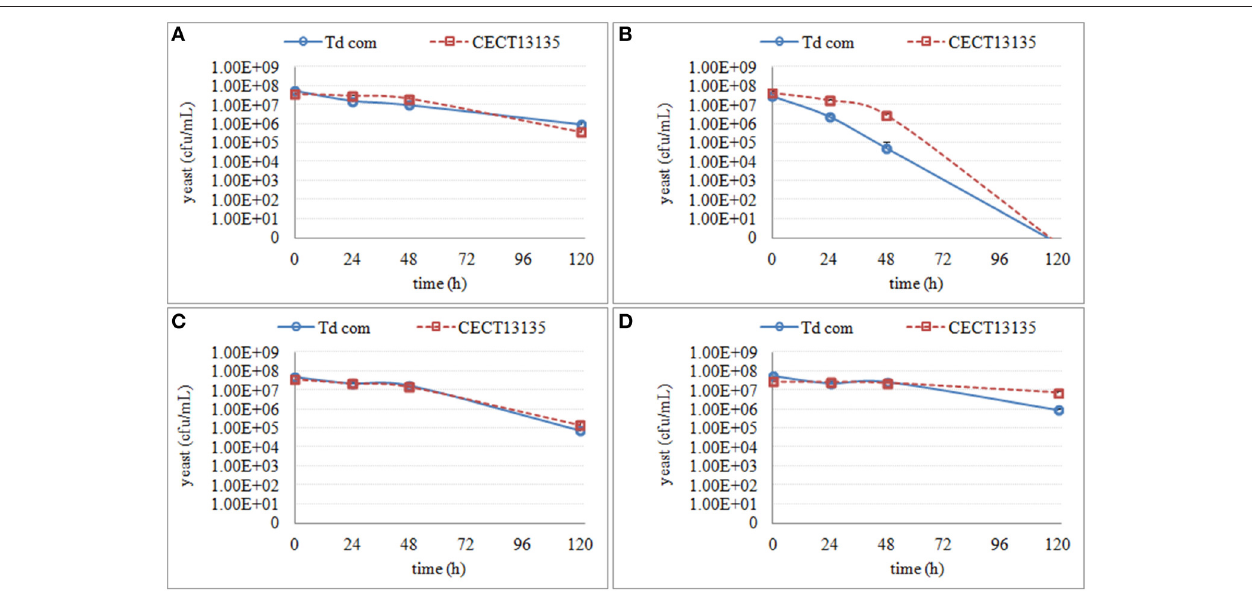
FIGURE 6 | The culturable population of two T. delbrueckii strains (Td com and CECT13135) grown in different synthetic media for 120h. (A) the growth in supernatant from the second stage of S. cerevisiae fermentation S-2 (B) the growth in supernatant from the third stage of S. cerevisiae fermentation S-3 (C) the growth in synthetic media MS-3 (D) the growth in synthetic media